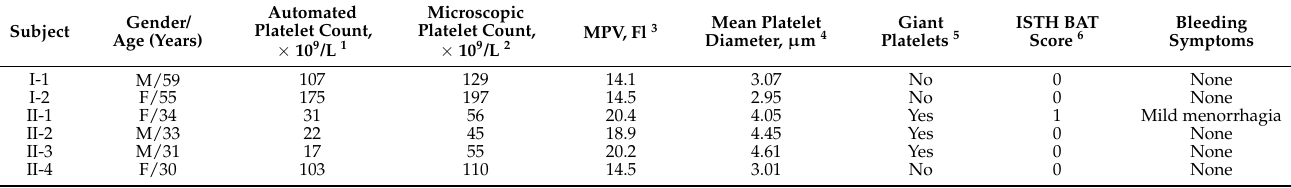
Table 1. Main clinical and laboratory features of the members of the reported family.